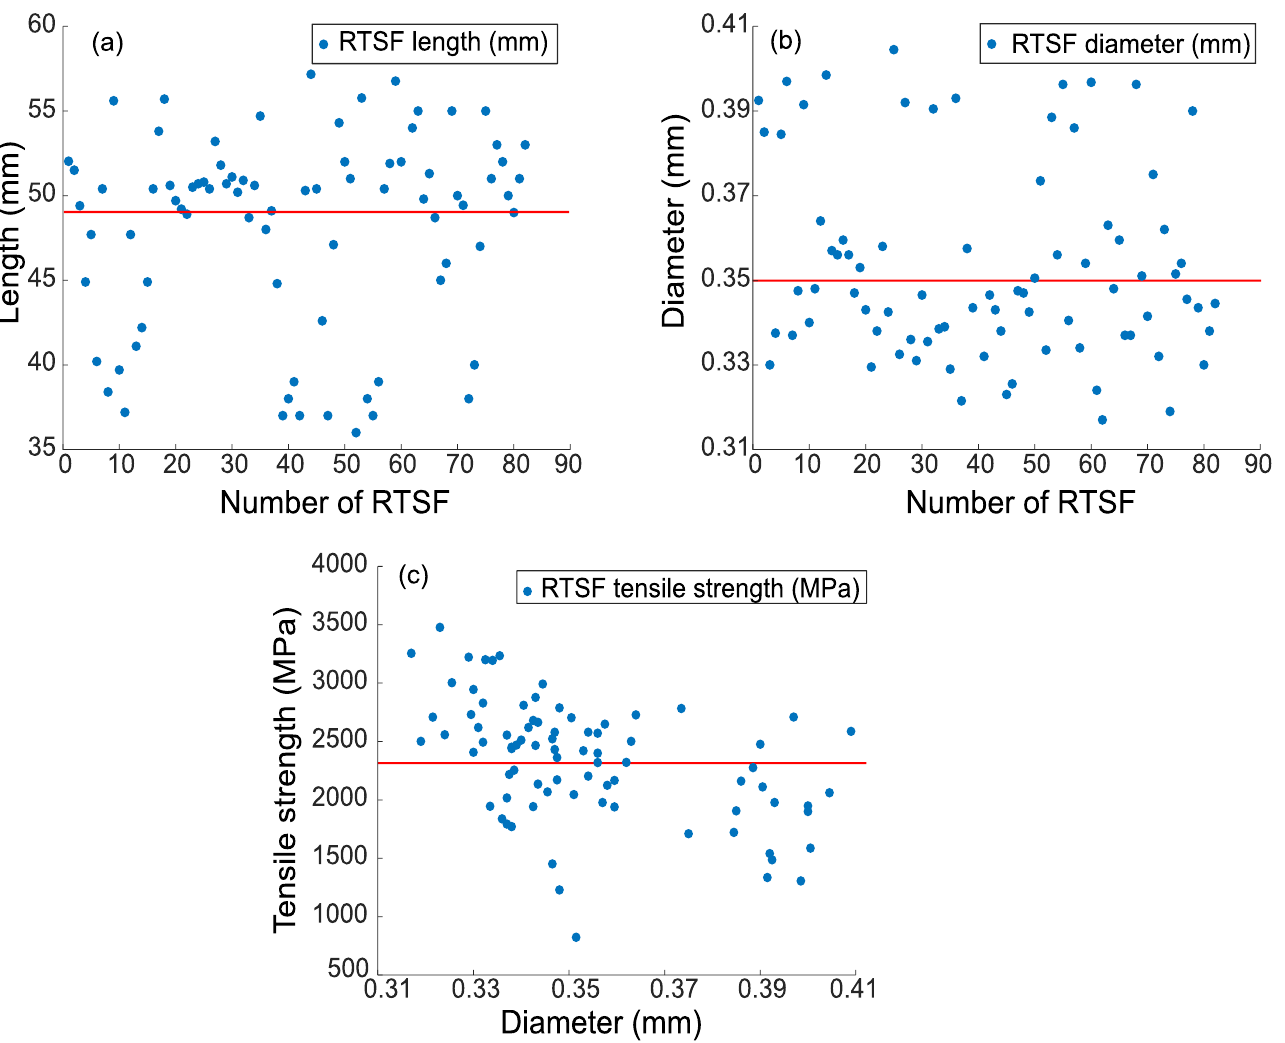
Figure 3. Appearance of ( a ) RTSF and ( b ) MSF.